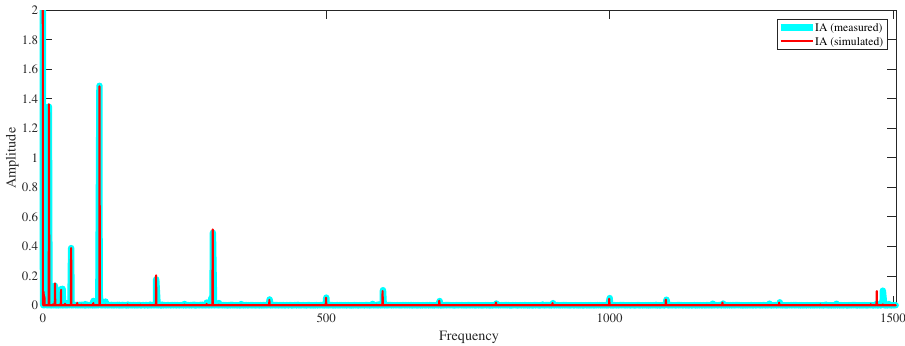
Figure 13. FFT of the measured and simulated IA .